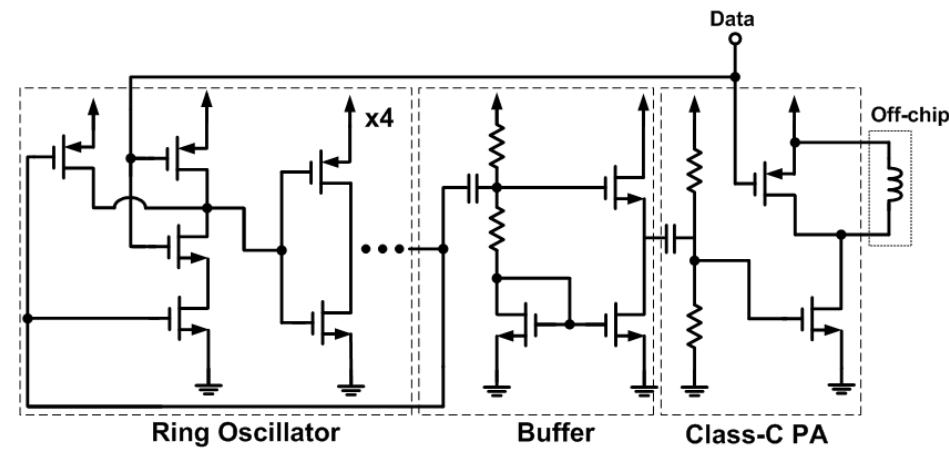
Figure 9. Circuit schematic of the transmitter.